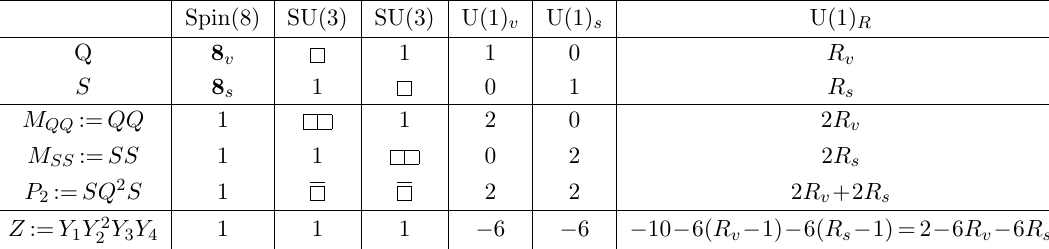
Table 4 . 3d N = 2 Spin(8) theory with ( N v ;N s ;N c ) = (3 ; 3 ;